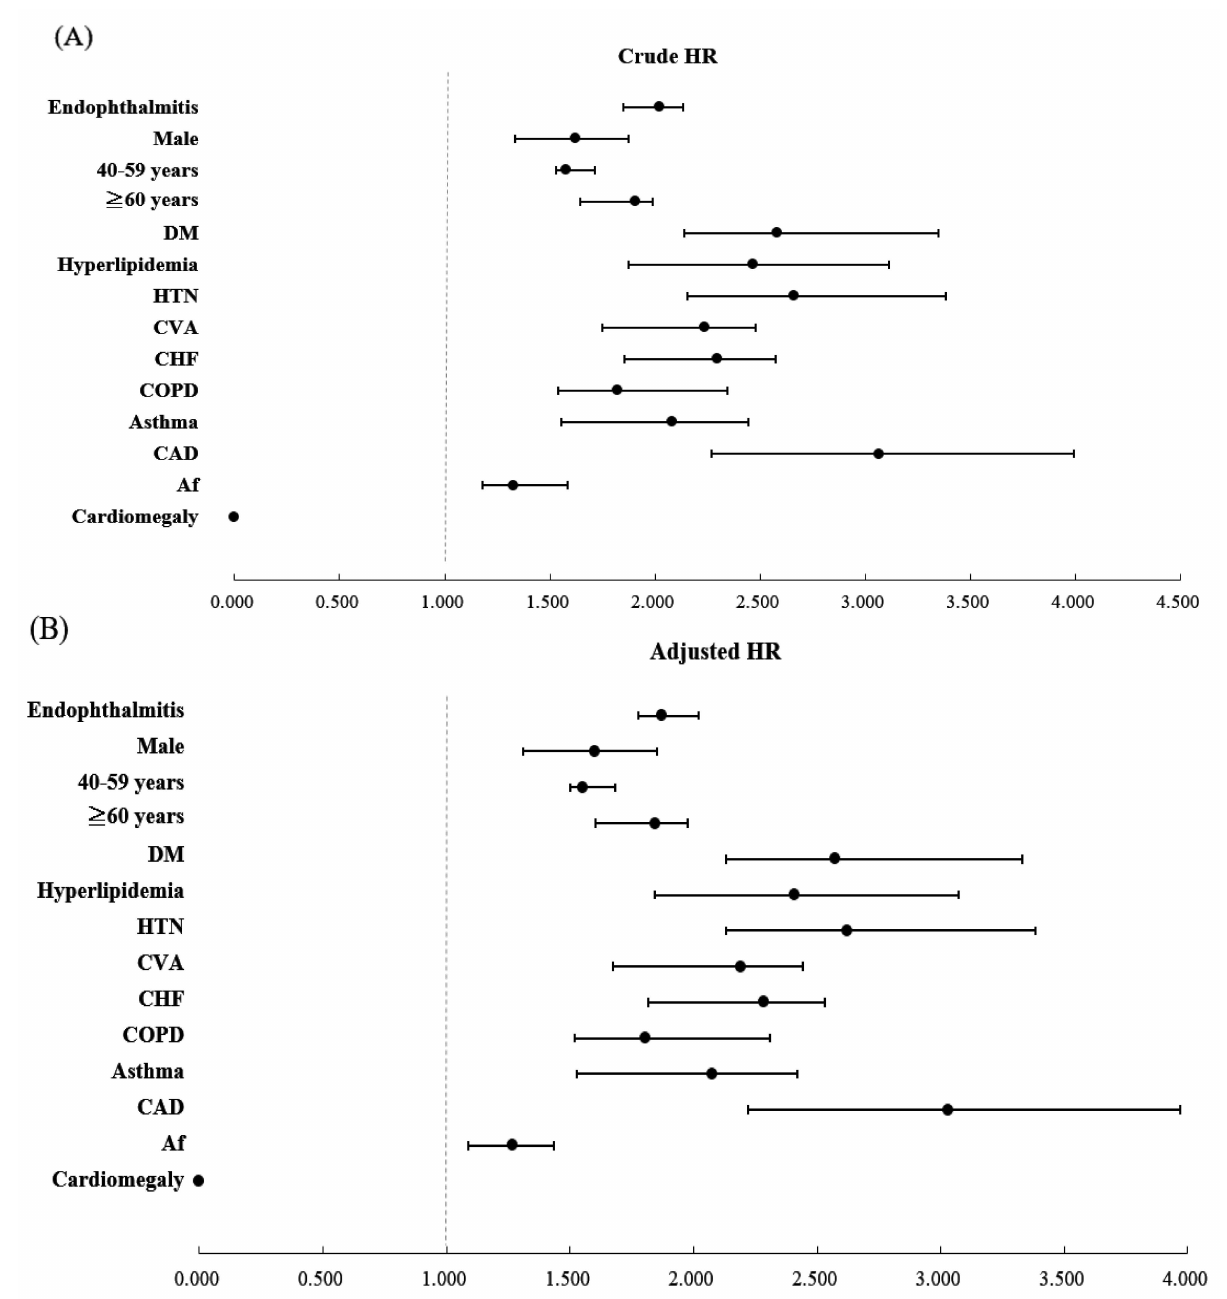
Figure 5. Forest plots of crude ( A ) and adjusted ( B ) hazard ratios for stroke factors evaluated